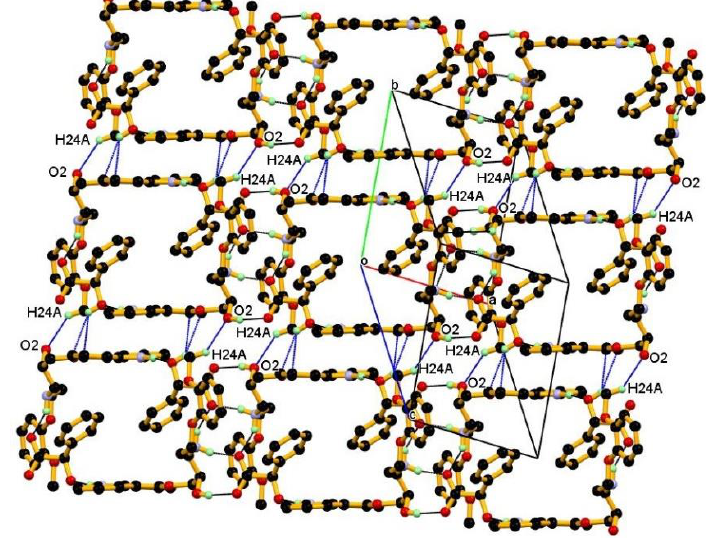
Figure 5. Packing of 1D-dimeric chain via weak C–H ··· O (C24–H24A ··· O2) and O–H ··· π (O5–5HA ··· Cg2) interaction along b -axis. Blue dotted lines indicate an association of neighboring chains.